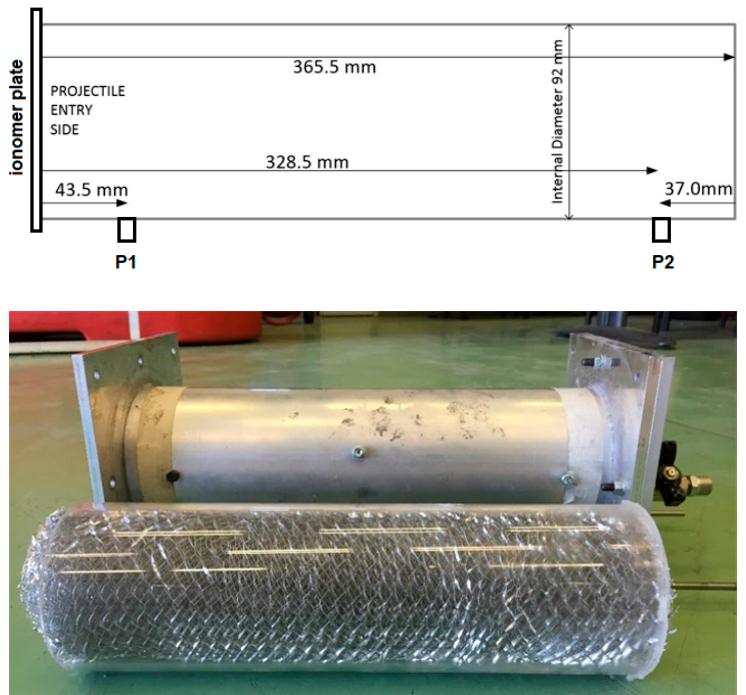
Figure 3. Fuel tank sketch indicating the location of the pressure gauges ( top ) and an image of the aluminium and transparent tanks (with Explosafe ® filler inside) ( below ).